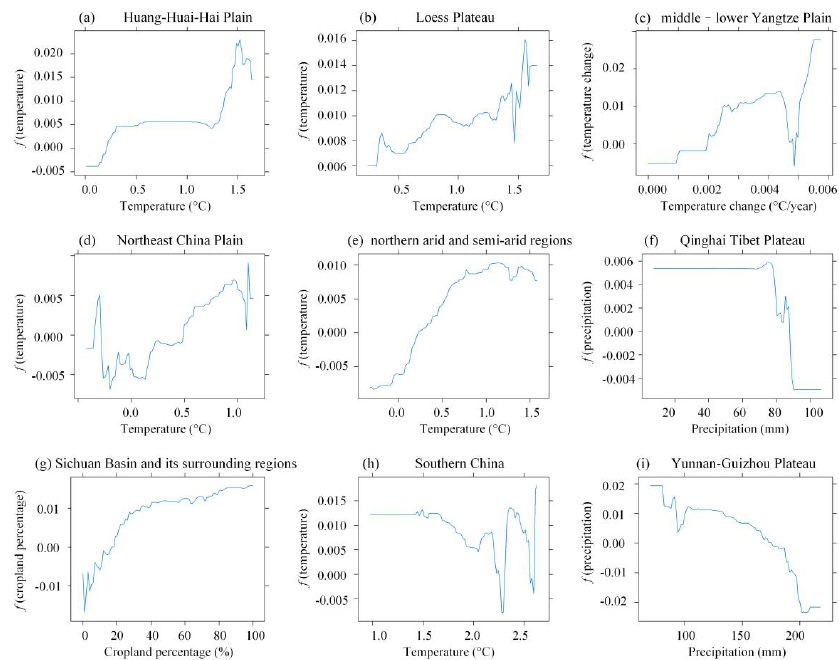
Figure 10. Partial dependence plots showing the relationships between GLASS LAI trends from 1982 to 2015 and their most important cropland and climate predictors in the ( a ) Huang-Huai-Hai Plain, ( b ) Loess Plateau, ( c ) middle–lower Yangtze Plain, ( d ) Northeast China Plain, ( e ) northern arid and semi-arid regions, ( f ) Qinghai Tibet Plateau, ( g ) Sichuan Basin and its surrounding regions, ( h ) Southern China, and ( i ) Yunnan-Guizhou Plateau agricultural zones.